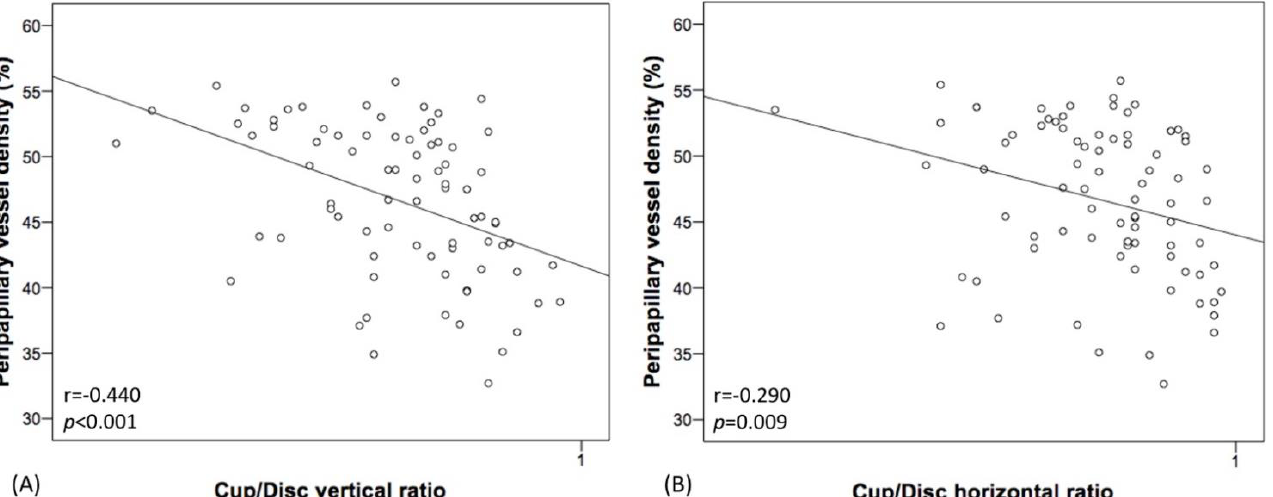
Table 1. Baseline characteristics of normal-tension glaucoma patients in this study.